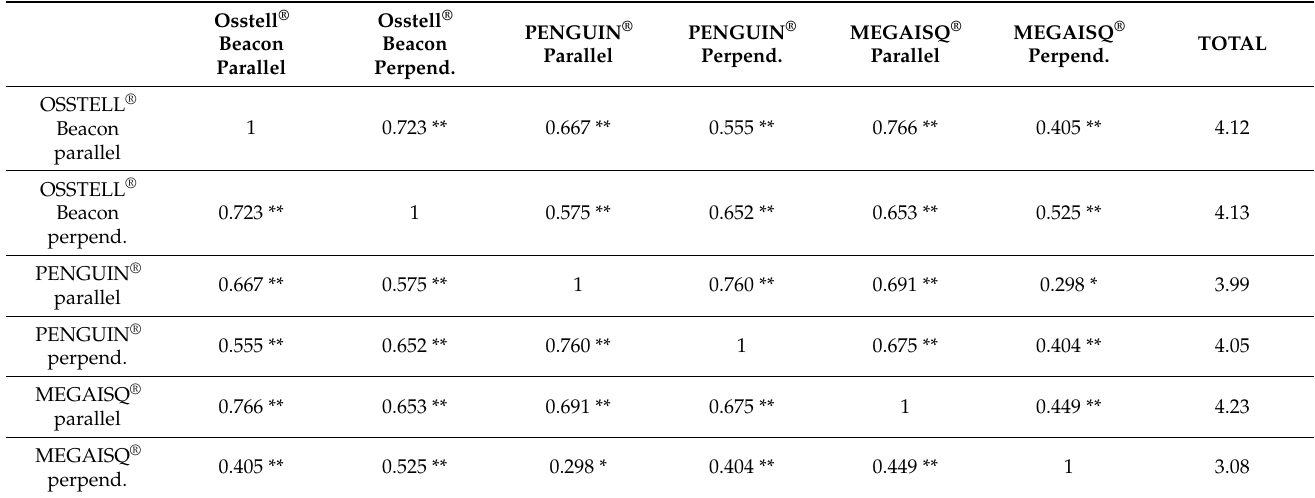
Table 3. Matrix of Pearson correlation coefficients for the different devices used to measure ISQ. Osstell ® Osstell ® MEGAISQ ® MEGAISQ ® PENGUIN ® PENGUIN ® TOTAL Beacon Beacon Perpend. Parallel Perpend. Parallel Parallel Perpend. 0.723 ** 0.667 ** 0.555 ** 0.766 ** 0.405 **